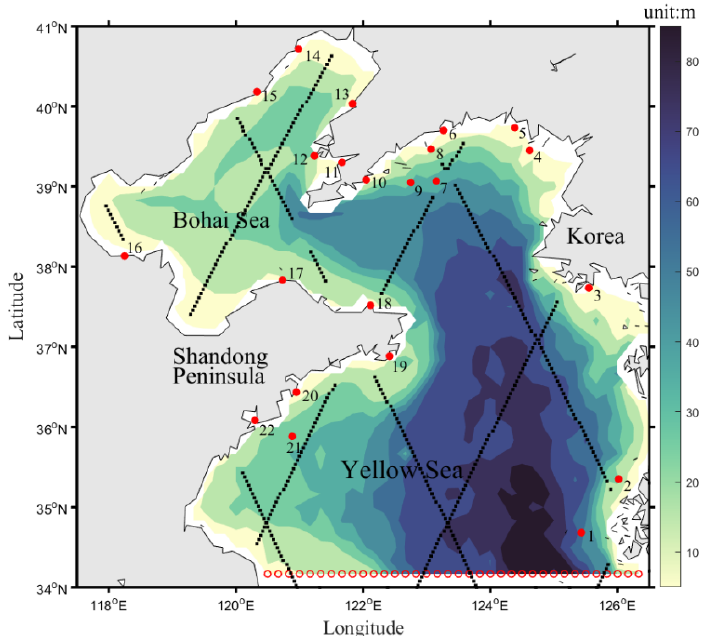
Figure 1. The bathymetry of the BYS, the location of open boundaries (red circles), the altimeter data (black points) and the tidal gauges (red points).